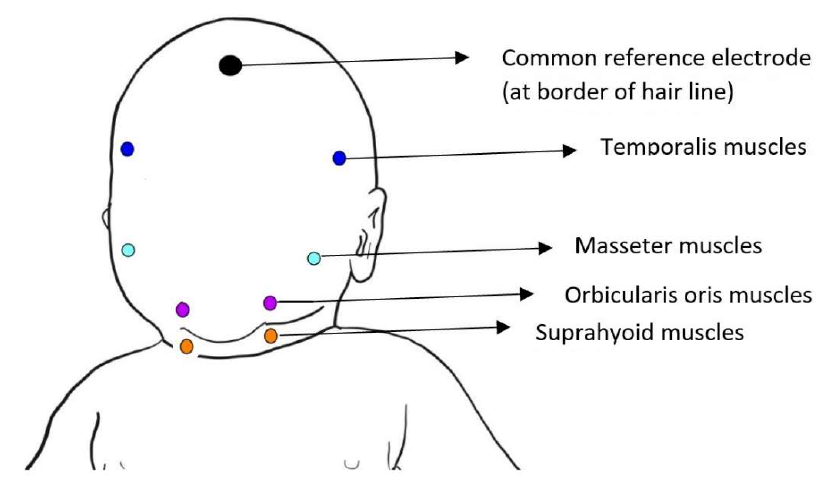
Figure 1. Electrode locations for measuring orofacial EMG activity.